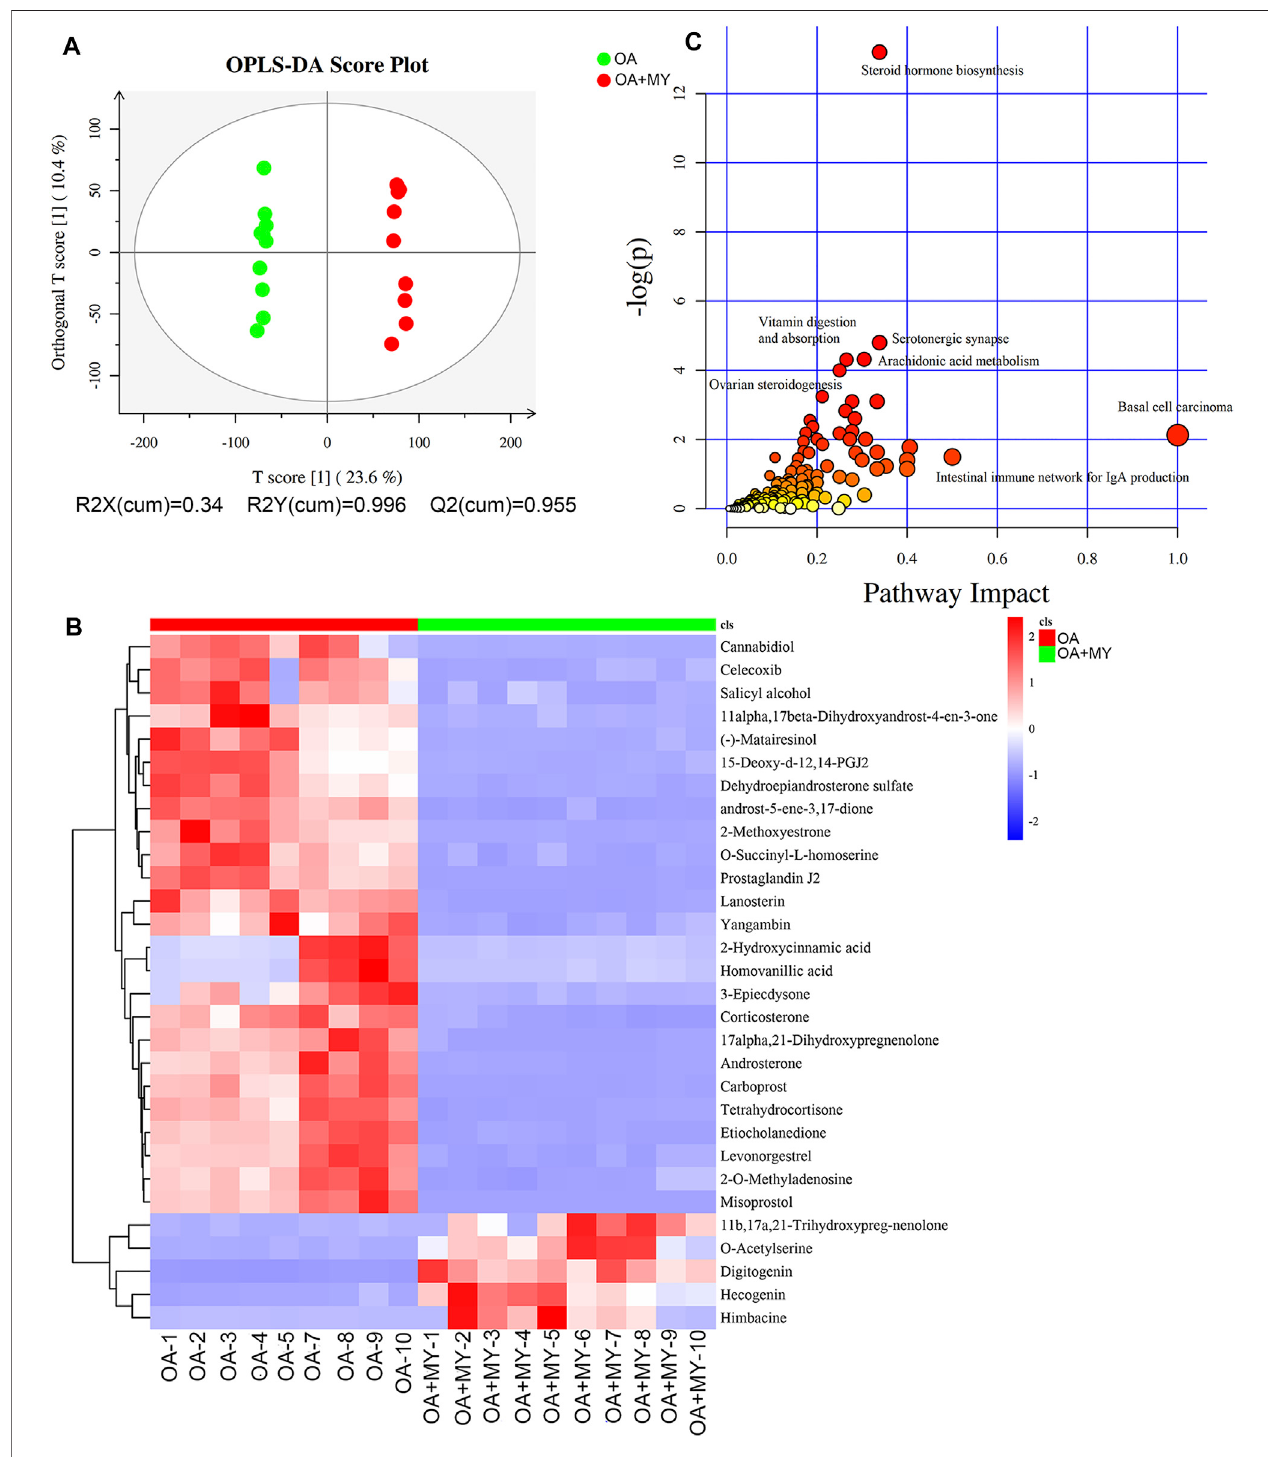
FIGURE 4 | Effects of MY on the fecal metabolomic pro fi les in OA. (A) Orthogonal projections to latent structures discriminant analysis (OPLS-DA) based on the fecal compounds data. (B) Agglomerate hierarchical clustering analysis of differential metabolites (Top30). (C) Kyoto Encyclopedia of Genes and Genomes pathways map of identi fi ed differential